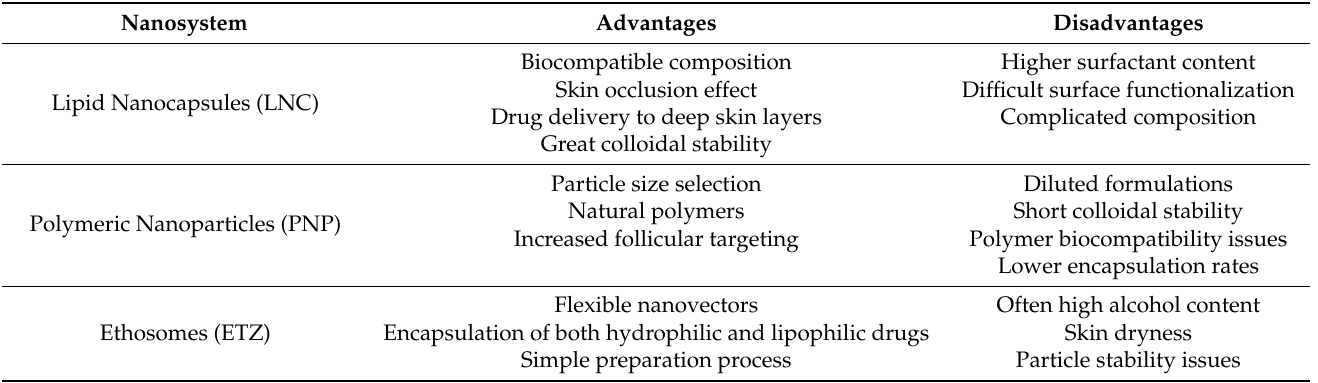
Table 1. The summary of advantages and disadvantages of nanosystems presented in this